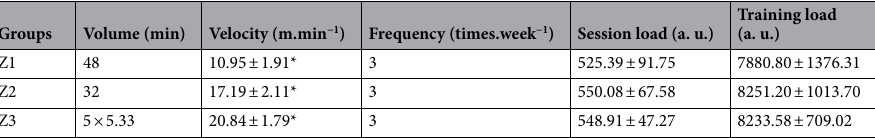
Table 2. Variables that compose the accomplished training sessions. Z1 = low intensity training group; Z2 = moderate intensity training group; Z3 = high intensity training group; MaxS = maximal running speed; a. u. = arbitrary units. * = statistically significant difference compared to the other two groups.